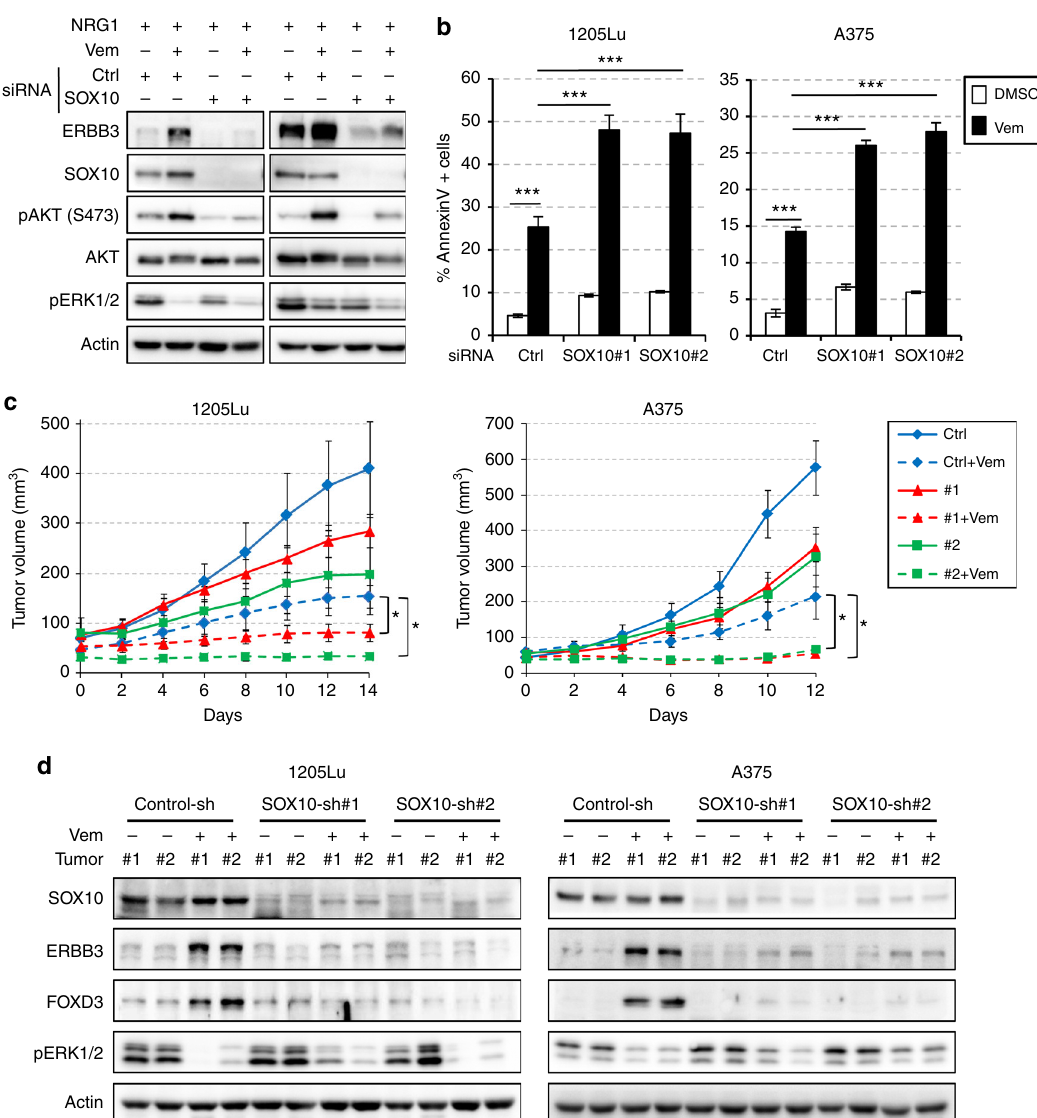
Fig. 7 SOX10 depletion sensitizes melanoma cells to mutant BRAF inhibitor. a Melanoma cells were transfected with control or SOX10 #2 siRNAs for 72 h and ± 2 μ M vemurafenib for additional 24 h. Cells were then stimulated with 10 ng ml – 1 NRG1 for 1 h and lysed for western blot analysis. b Melanoma cells were transfected with Control, SOX10#1 or #2 siRNAs for 48 h and treated with ± 10 μ M Vemurafenib for additional 48 (1205Lu) or 72 (A375) hours. Cells were then collected and stained with Annexin-V/PI for fl ow cytometry analysis. Average percent of annexin-V positive cells from three independent experiments are shown. Error bars represent standard deviation. Signi fi cance was determined by ANOVA one-way test, *** p < 0.001. c Growth curves of tumors formed by 1205Lu-TR or A375-TR cells harboring control or SOX10-shRNAs in nude mice ( N = 7 per condition). Statistical analyses (ANOVA test) were performed on tumor volume differences between RAFi-treated control-shRNA group and RAFi-treated SOX10-shRNA groups on day 12 (A375) or 14 (1205Lu). Error bars represent standard error. Signi fi cance was determined by ANOVA one-way test, * p < 0.05. d Western blot analysis of two sets of representative tumor samples excised on day 5. Uncropped images are shown in Supplementary Fig.